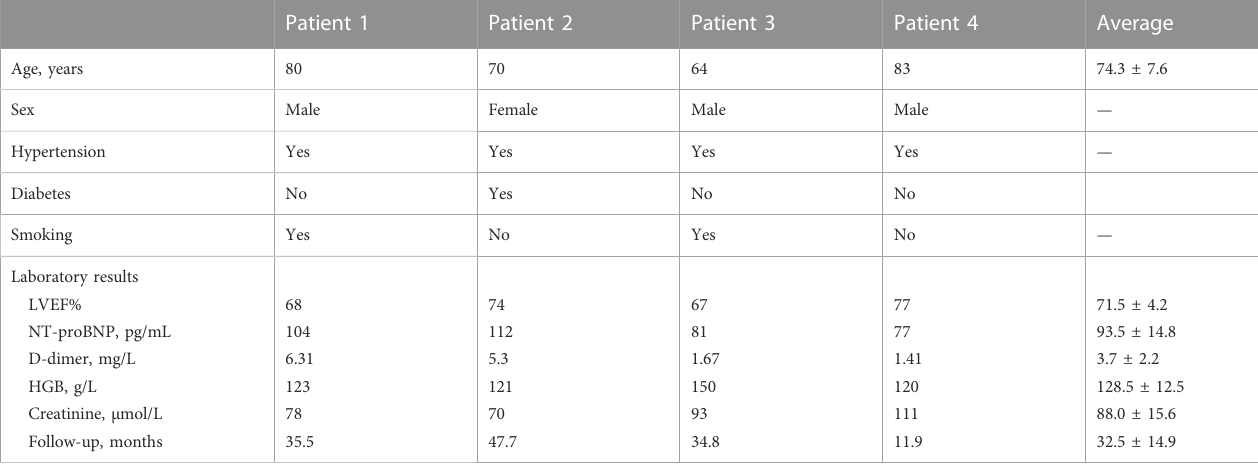
TABLE 1 Clinical information and total BP levels of patients under different heart